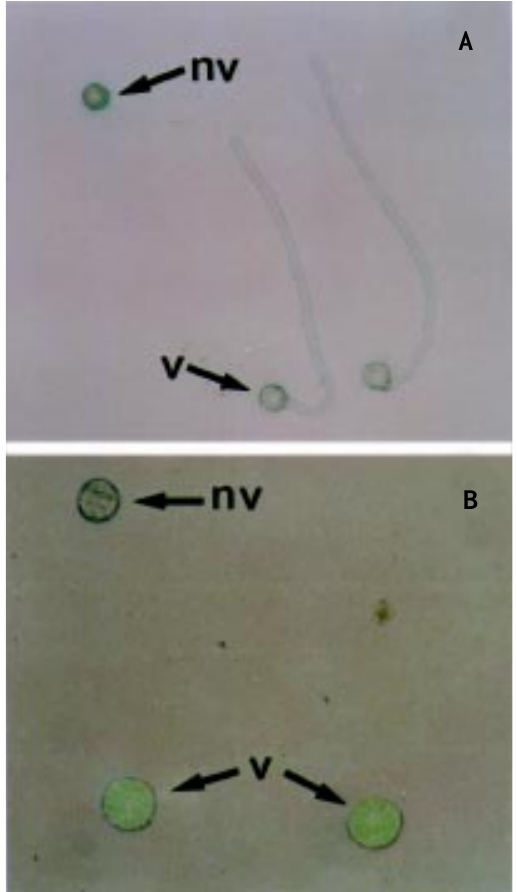
Figure 7 - Viability of G9-RNase transgenic tobacco clones RN1-RN5 and nontransformed Nicotiana tabacum ‘Havana 425’ ( WT ) at anther develop- mental stage 10. A , Percentage of viable pollen grains germinating on Mi- cro Art’s media (see Figure 6A). B , Percentage of viable fluorescent pollen grains (see Figure 6B). A minimum of 100 pollen grains were counted per sample, in at least three independent